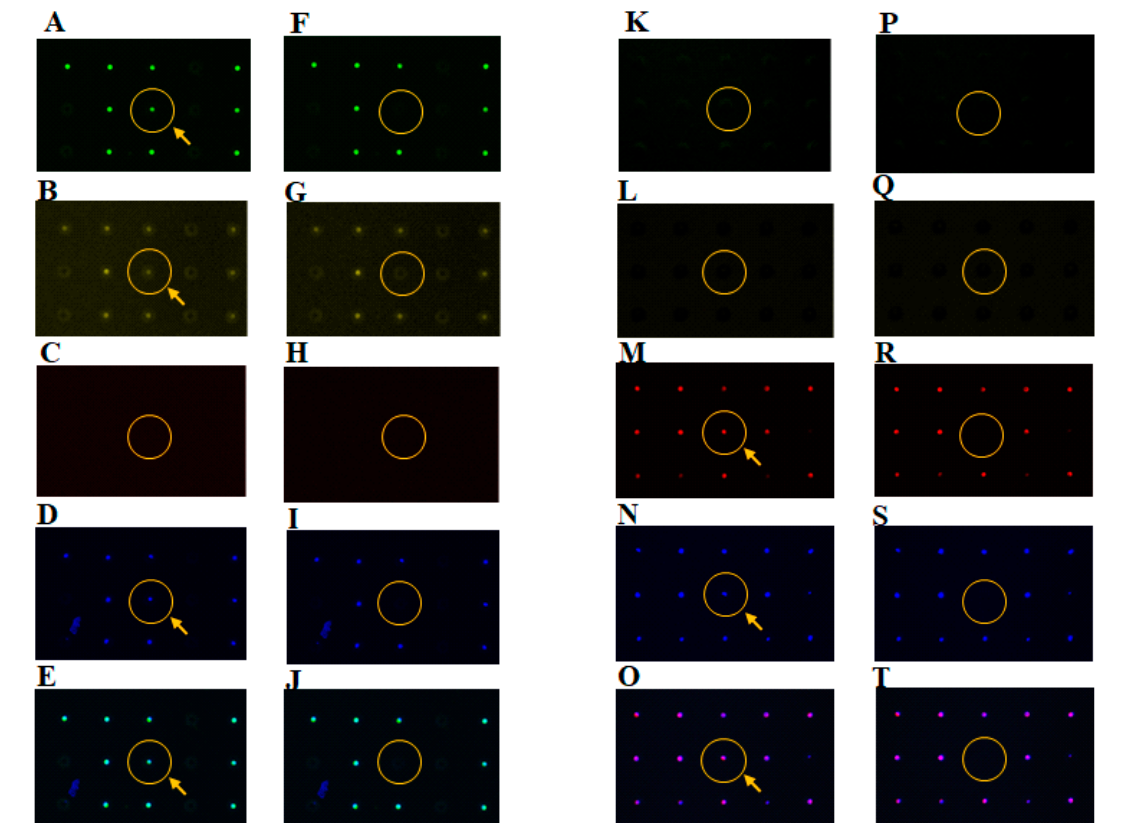
Figure 7. Retrieval of single cells from the microchambers using a micromanipulator. Fluorescence microscopic images of single ( A – J ) NCI-H1650 and ( K – T ) CCRF-CEM cells on the single-cell microarray chip ( A – E , K – O ) before and ( F – J , P – T ) after cell retrieval using a micromanipulator. NCI-H1650 and CCRF-CEM cells were multi-stained with ( A , F , K , P ) PE-labeled anti-cytokeratin, ( B , G , L , Q ) Alexa Fluor 488-labeled anti-EpCAM, ( C , H , M , R ) Alexa Fluor 647-labeled anti-CD45, monoclonal antibodies, and ( D , I , N , S ) DAPI. ( E , J , O , T ) Merged images. Arrows indicate multi-stained single